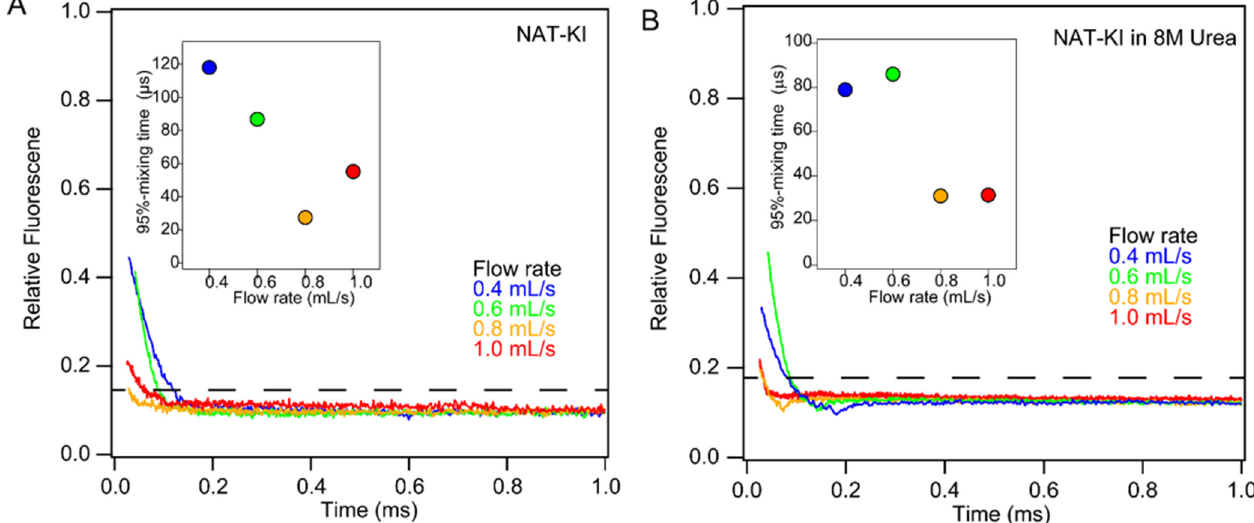
Figure 5. Mixing efficiency of Mixer 3 vs. flow rate assayed using potassium iodine quenching of tryptophan fluorescence. Residual fluorescence of NAT (10 mM) upon mixing with 1 mM potassium iodide in the absence ( A ) and presence ( B ) of 8 M urea. Color code: 0.4 mL/s (blue), 0.6 mL/s (green), 0.8 mL/s (orange) and 1.0 mL (red). The 95% mixing level is shown by the broken lines. The inlet panels show the time to achieve 95% mixing.